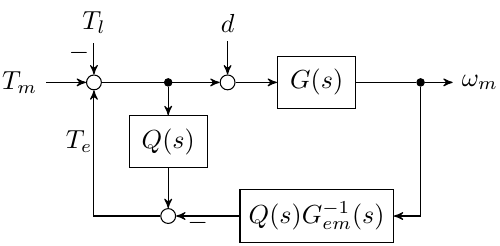
Figure 2. The concept of the proposed method using the disturbance-observer